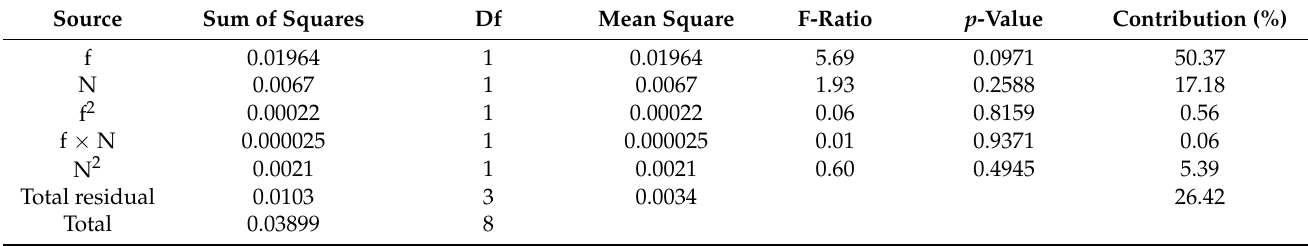
Table 7. Analysis of variance for